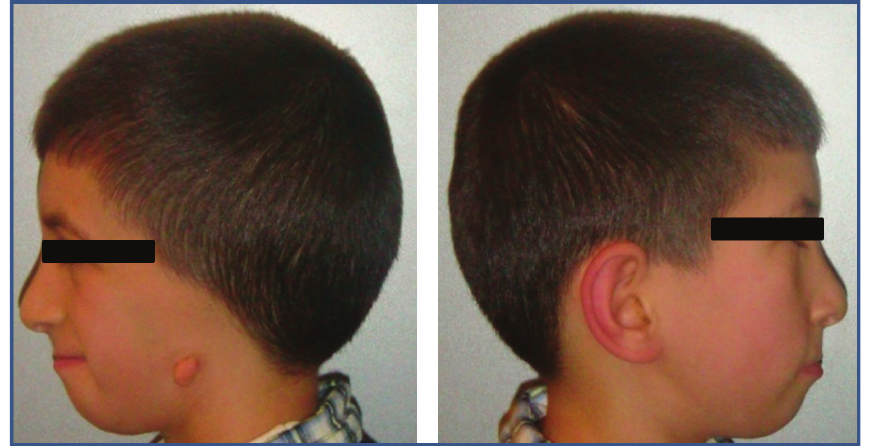
Figure 2: Lack of development of the internal and external ear with related hearing problems and severe mandibular hypoplasia with